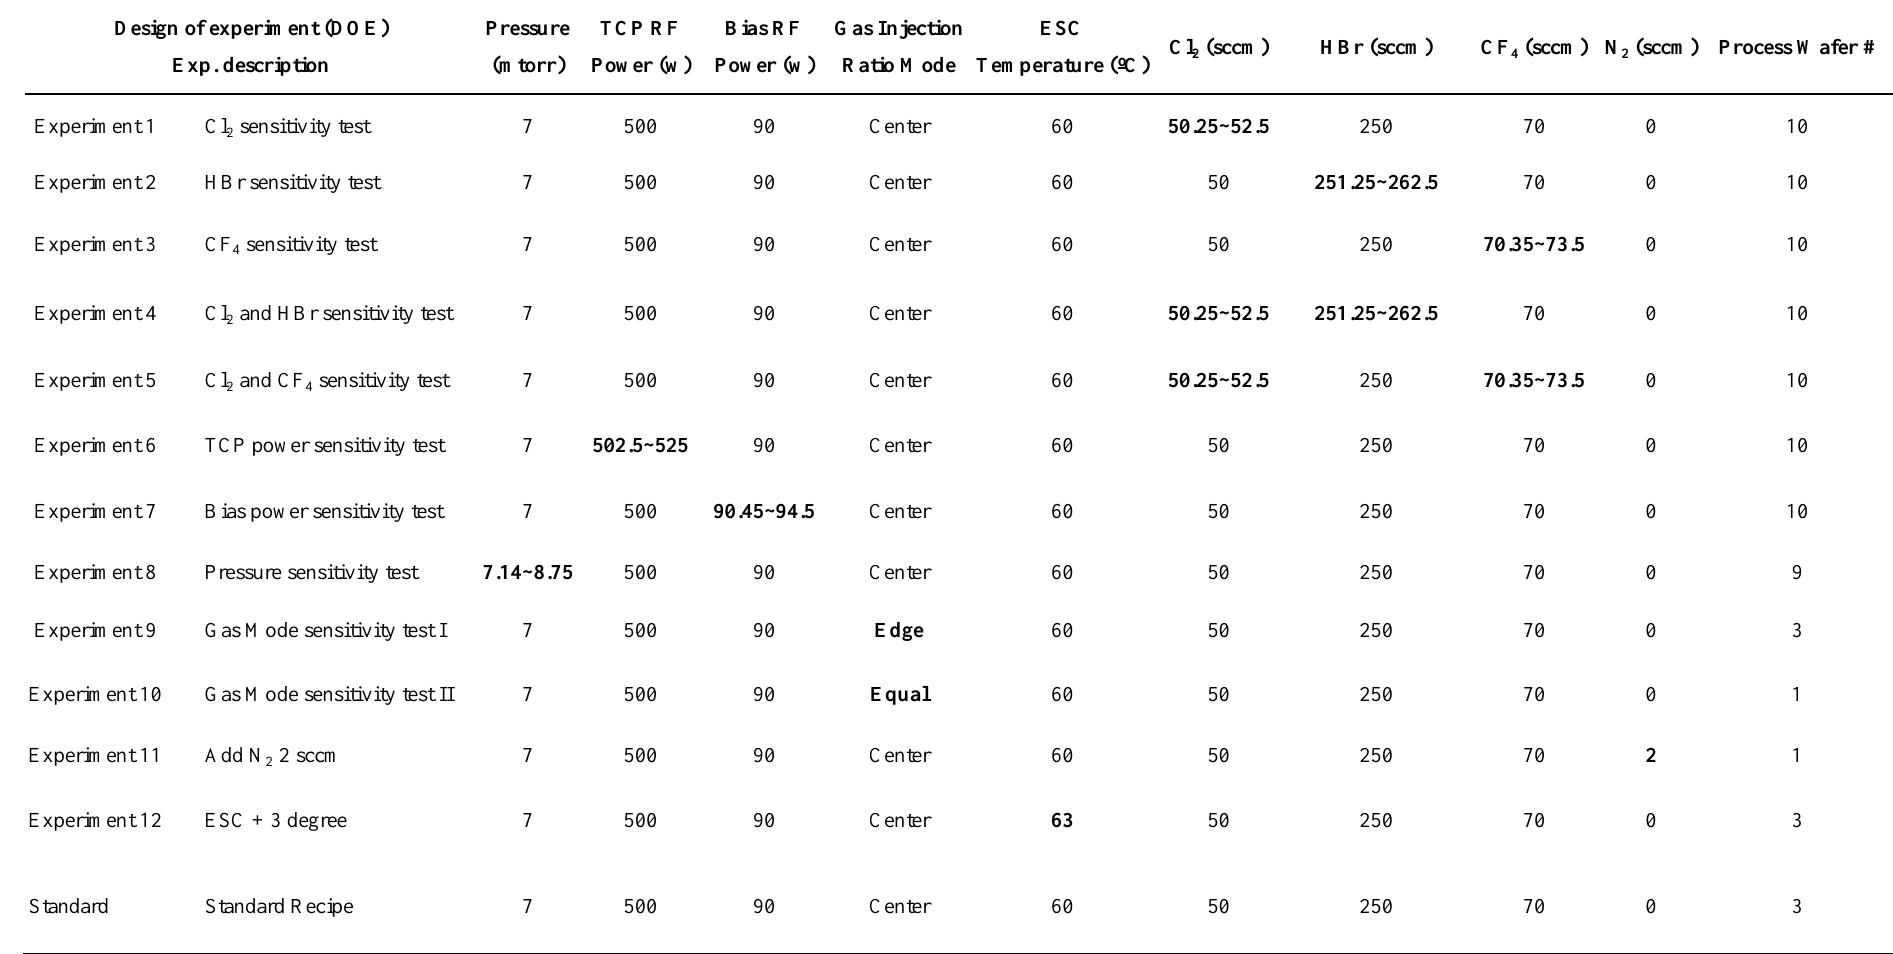
Table 1. Design of experiments (DOE) for process shift